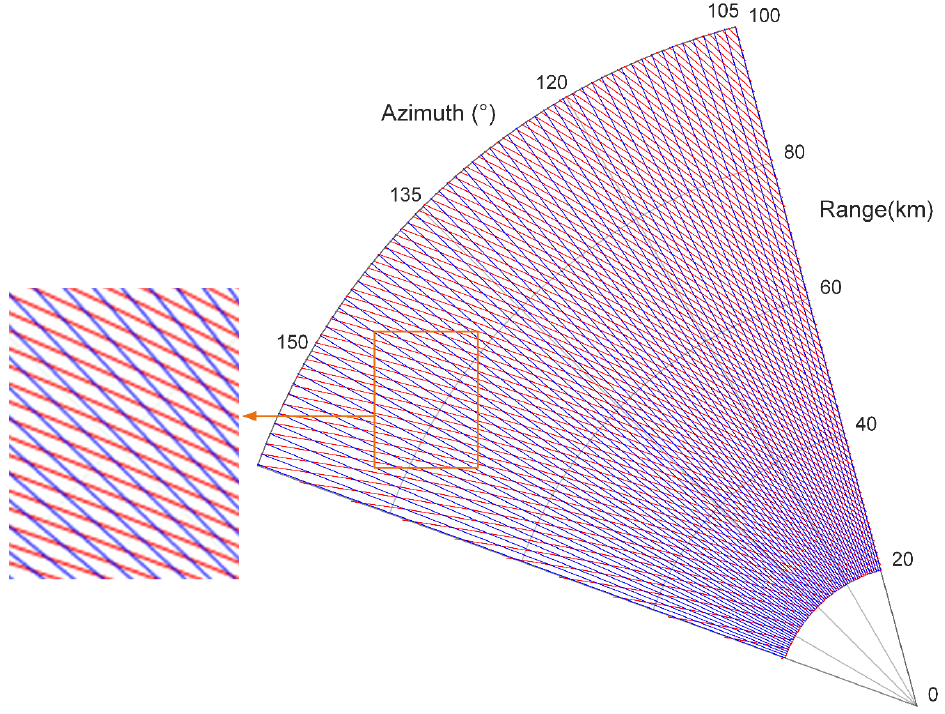
Figure 3. An example map of the proposed polar grid .